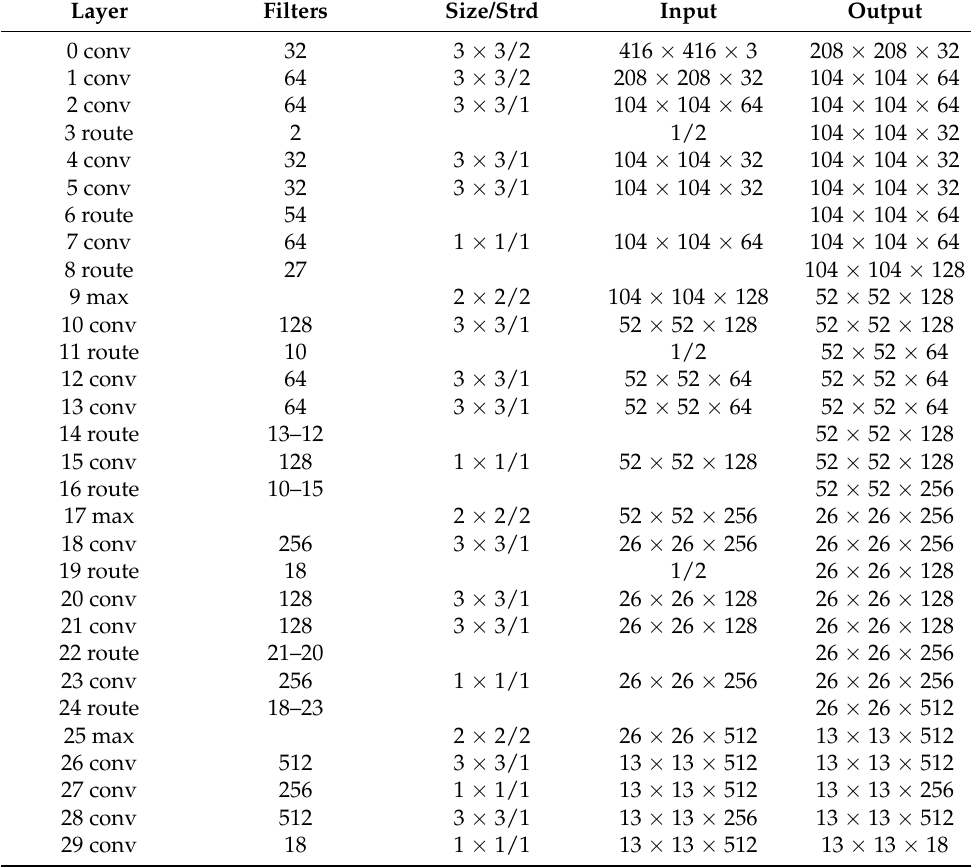
Table 3. LP detection model